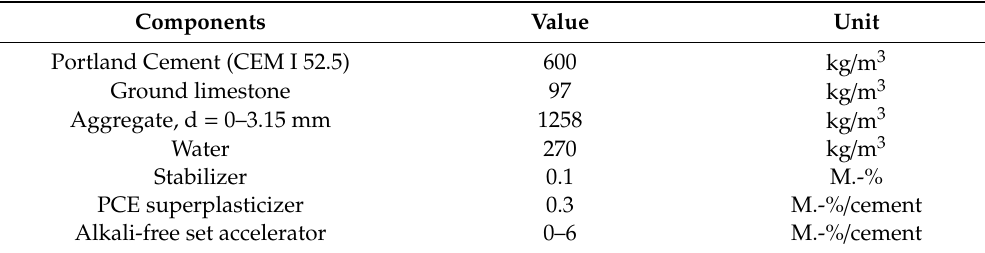
Table 2. Mixture compositions of used